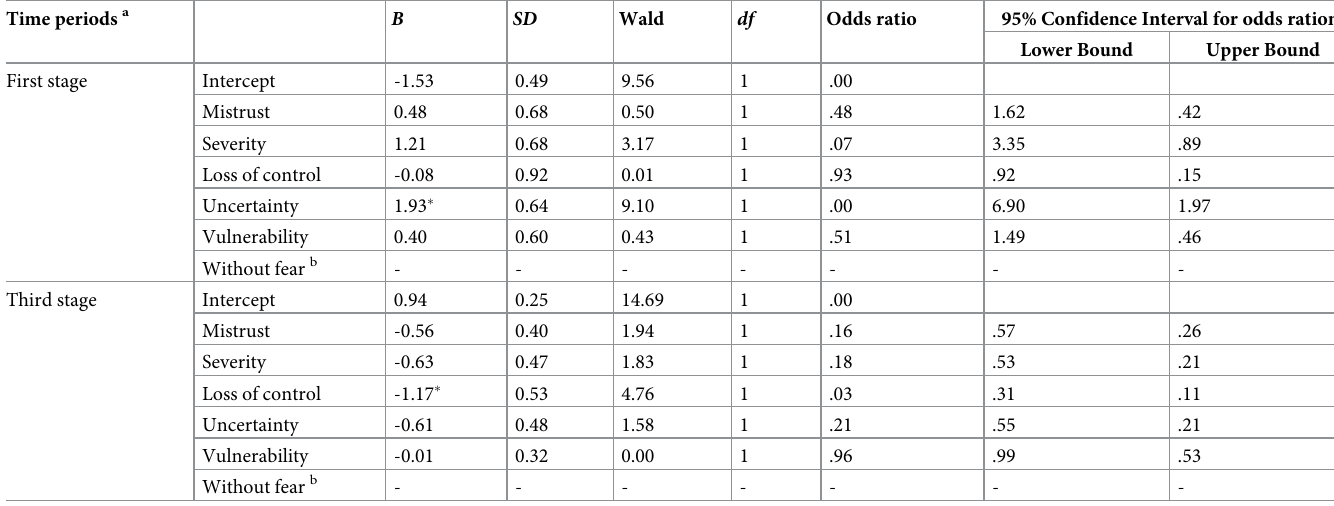
Table 5. Results of the multinomial logistic